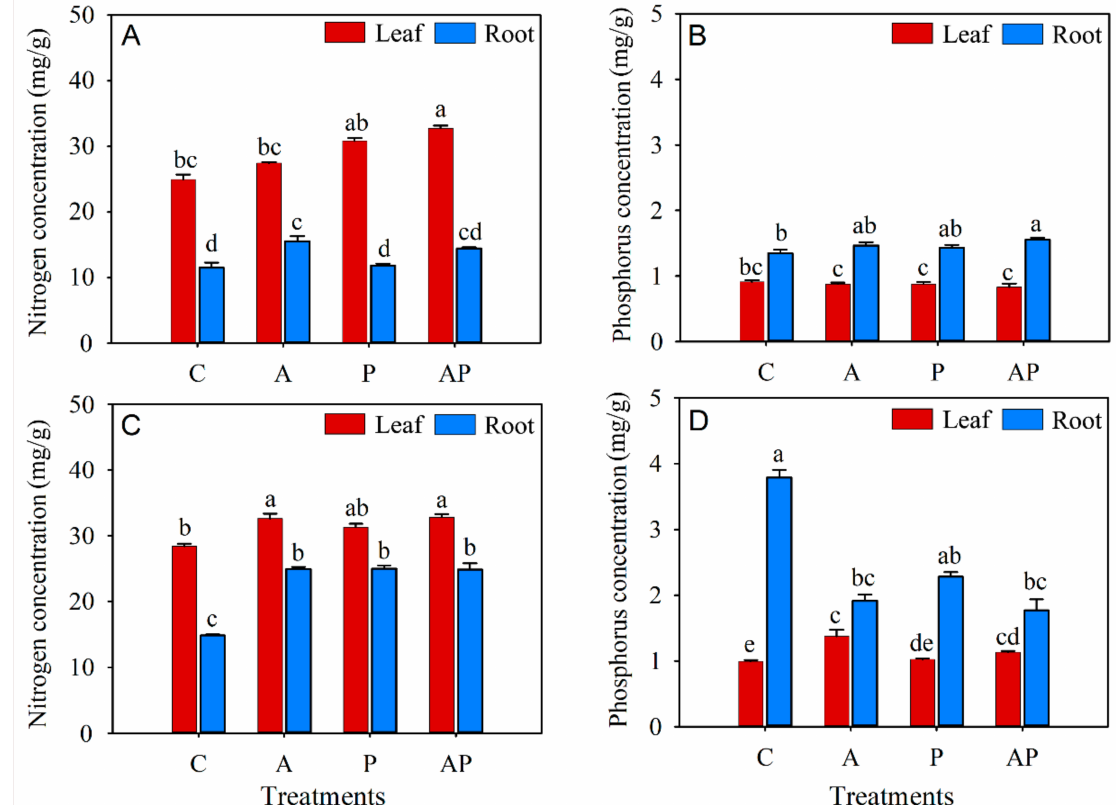
Figure 4. Effects of AMF and PGPR inoculation on the N ( A , C ) and P ( B , D ) concentrations in Nitraria tangutorum Bobr. (first row) and Elaeagnus angustifolia Linn. (second row). Each value represents the mean of three replicates. Each bar represents the standard deviation of three repli- cates. Values are significantly different at the 0.05 level (Tukey’ test) if followed by different letters above the bars. C: control, A: AMF inoculation treatment, P: PGPR inoculation treatment, AP: co-inoculation